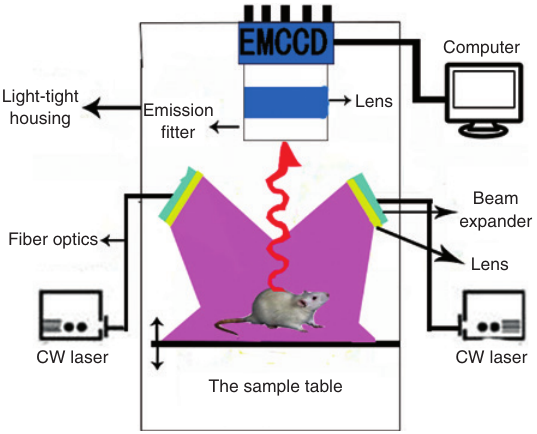
Figure 2: Diagram depicting the experimental setup for the small- animal upconversion luminescence imaging system. Reprinted with permission from Ref.